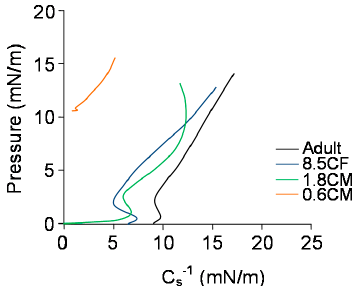
Figure 4. Reciprocal compressibility modulus as a function of surface pressure for meibum films of infants, children, and adults at 35 °C at the air-artificial tear interface.